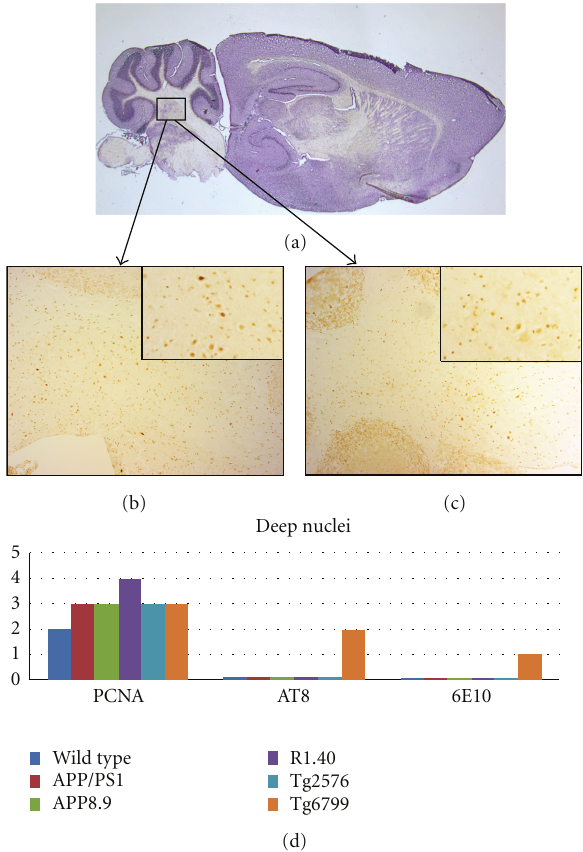
Figure 4: Comparison among the mouse lines studied with respect to the presence of cell cycle events (PCNA), tau-phosphorylation (AT8), and beta-amyloid plaque deposition (6E10) in the deep cere- bellar nuclei. (a) Sagittal section of a wild-type mouse brain indicat- ing the approximate location of the deep nuclei. (b) PCNA-positive neurons are illustrated by their appearance in this representative section from the Tg2576 mouse model. (c) Curiously, some PCNA immunostaining is also seen in wild-type mice as illustrated in this representative micrograph. The insets in both (b) and (c) are representative fields shown at higher magnification to illustrate the qualities of the cell cycle staining. (d) Quantification of the extent of immunostaining for the cell cycle, phospho-tau, and beta-amyloid plaques in the five transgenic models plus wild type.